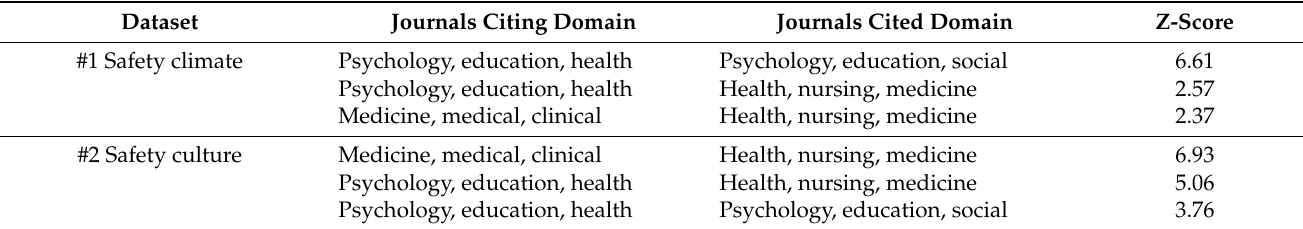
Table 4. Citation trends in safety culture and safety climate at a domain level.